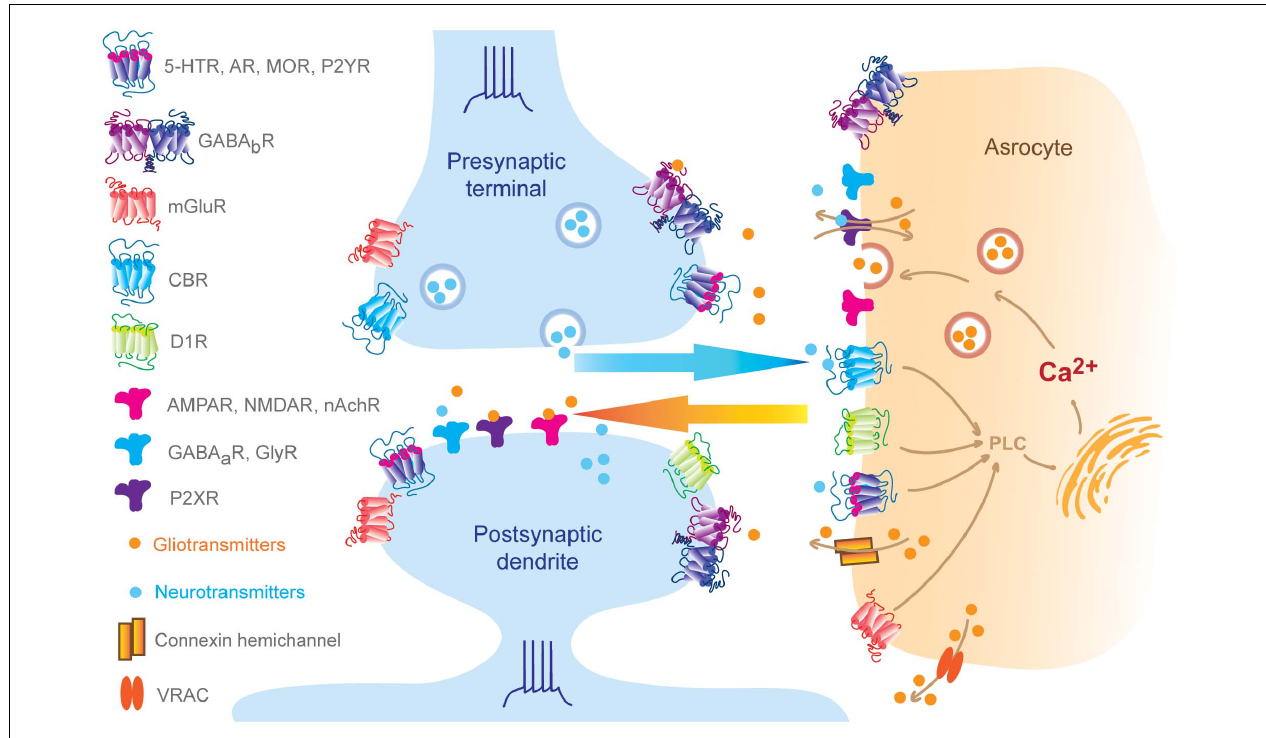
FIGURE 1 | Bidirectional neuron-astrocyte signaling. Pre-synaptic neurotransmitters and post-synaptic release endogenous cannabinoids that bind to astrocytic GPCRs and ion channels, which result in elevation of intra-astrocyte calcium concentration and trigger gliotransmitter releasing, in turn, perisynaptic gliotransmitters bind to synaptic receptors regulating synaptic behaviors (Volterra and Meldolesi, 2005; Hamilton and Attwell, 2010; Benarroch, 2016; Kofuji and Araque, 2020). Of note, subset of AMPA receptors can be found at pre- and post-synaptic membrane and also astrocytes, such as GluR2 in the cerebellum (Matsuda et al.,